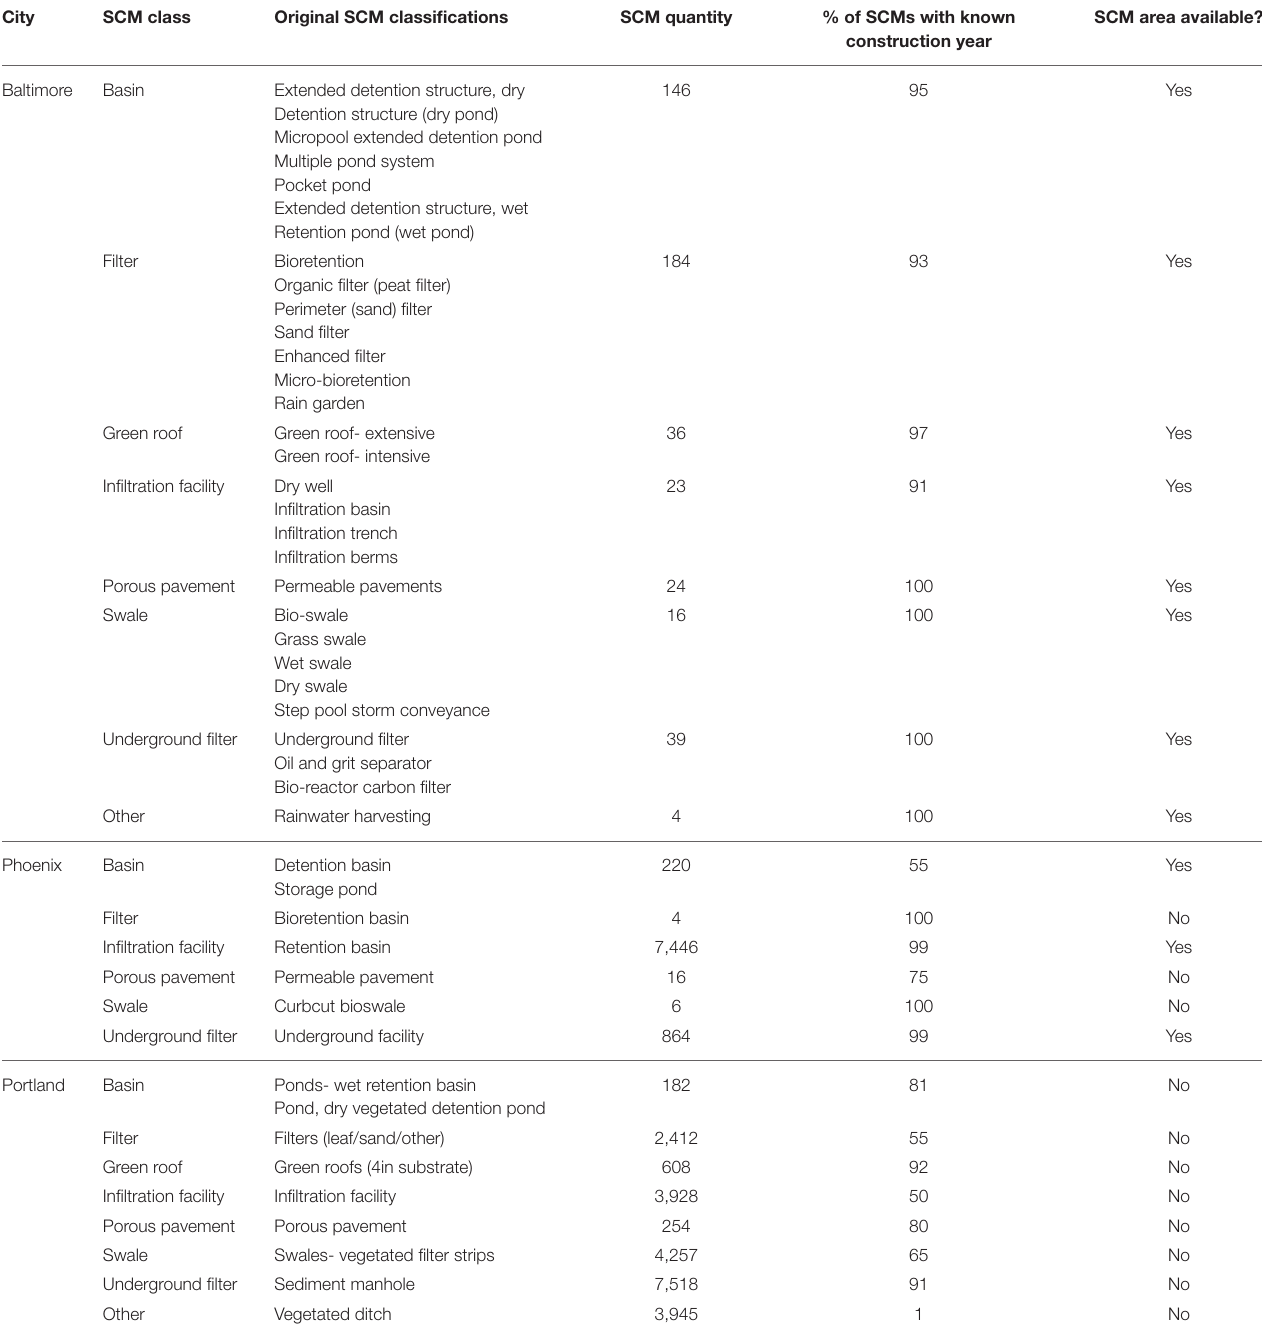
TABLE 2 | Summary of Stormwater Control Measure (SCM) data, including the original SCM classifications according to each city, the new classification used in this analysis (which often aggregates multiple original classes), total quantity of SCMs, and availability of associated characteristics.